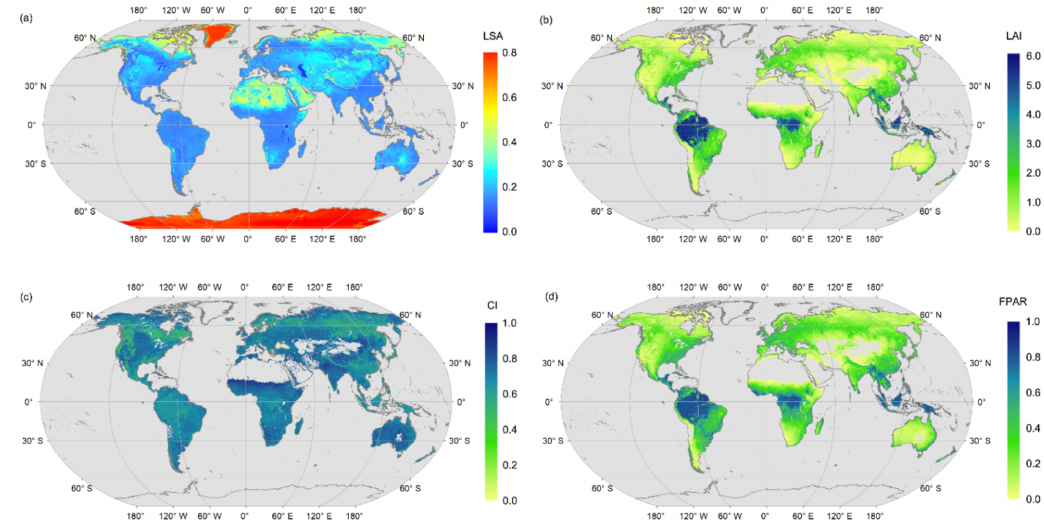
Figure 3. Spatial distributions of the annual mean LSA, LAI, CI, and FAPR from 2000 to 2019. ( a ) LSA, ( b ) LAI, ( c ) CI, and ( d ) FPAR. The pixels with no data are colored grey.